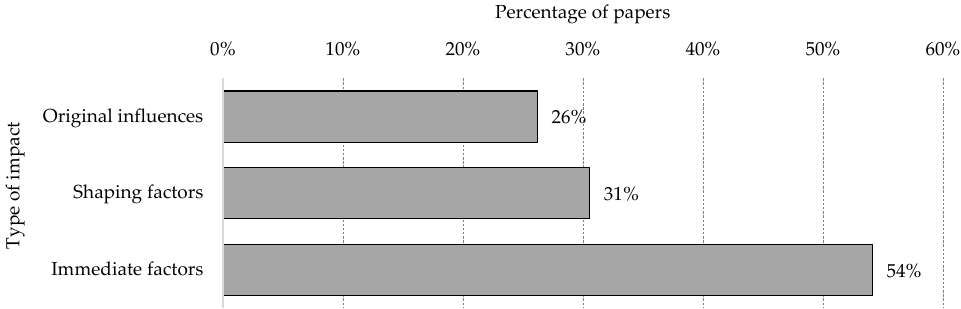
Figure 12. Presence of the factors in the review by types of impacts according to the CACF.